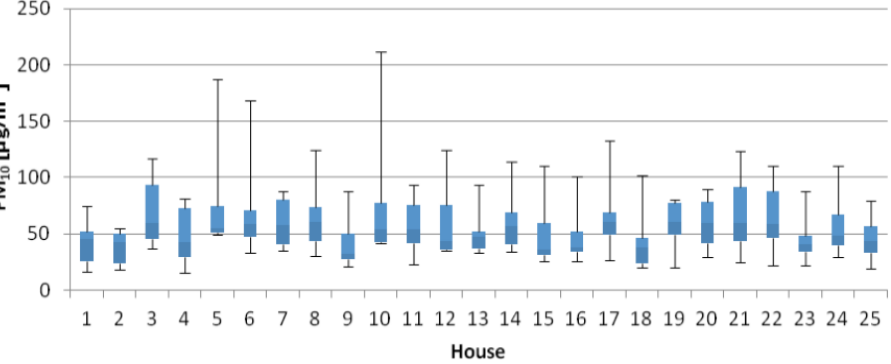
Figure 2. Box plot of PM 10 concentrations.